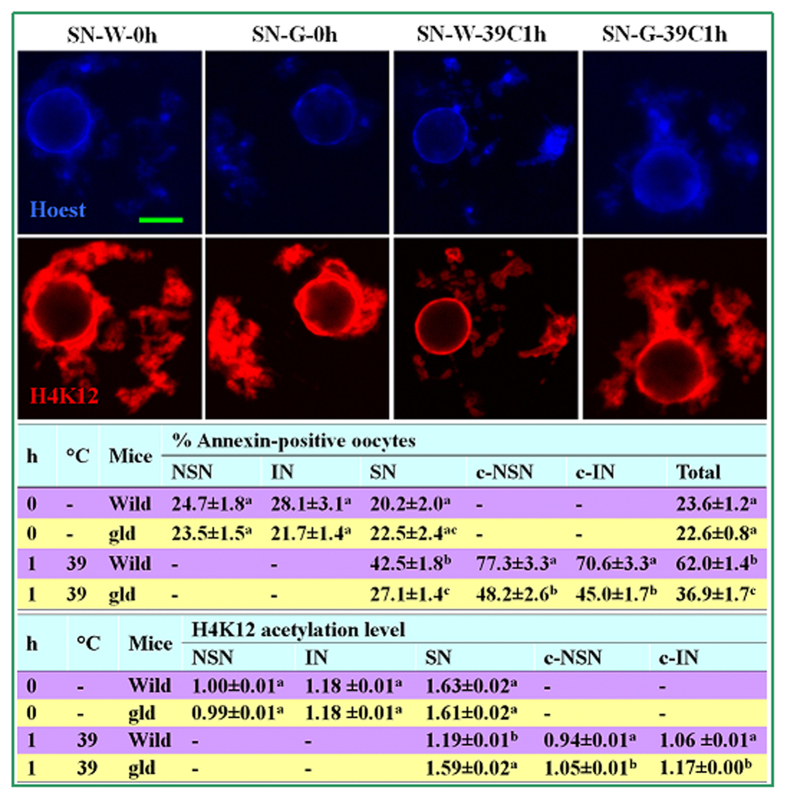
Percentages of annexin-positive oocytes and levels of H4K12 acetylation in oocytes with different chromatin configurations after OH under different conditions in wild-type and gld prepubertal mice.The micrographs are laser confocal images of SN oocytes in which Hoechst 33342 (upper row) and H4K12 (lower row) were pseudo-colored blue and red, respectively. Original magnification × 200. Scale bar is 10 μm. Images in the same column are from the same oocyte observed at different optical wavelengths. The SN oocytes shown in different columns include oocytes before OH (0 h) or after OH at 39 °C for 1 h (39C1h) from wild-type (W) or gld (G) mice. The two tables show % annexin-positive oocytes and relative levels of H4K12 acetylation among different oocytes, respectively. Each treatment was repeated 4 times with each replicate containing about 30 oocytes. a–c: Values in the same column without a common letter in their superscripts differ (P < 0.05).